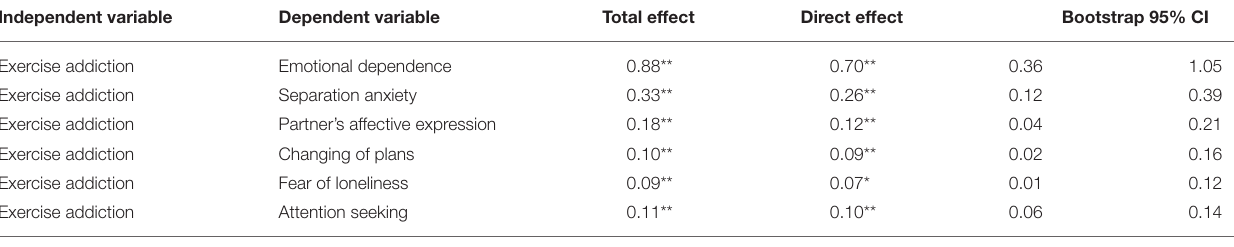
TABLE 5 | Mediation of attachment dimensions in the relationship between exercise addiction and emotional dependence. Independent variable